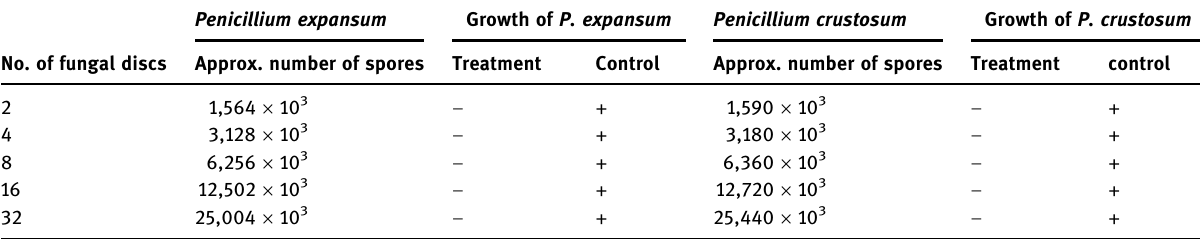
Table 7: E ff ect of increased inoculum density on fungitoxicity of the thyme oil Penicillium expansum Growth of P.